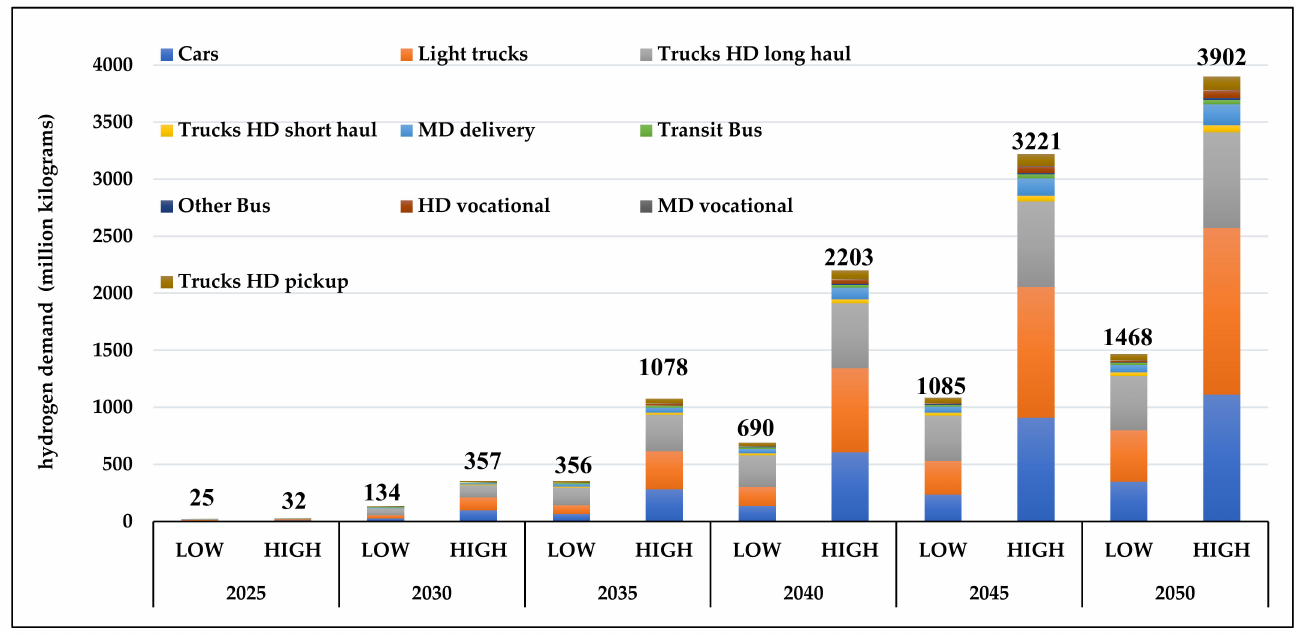
Figure 2. Annual hydrogen demand projection scenarios from on road transport in